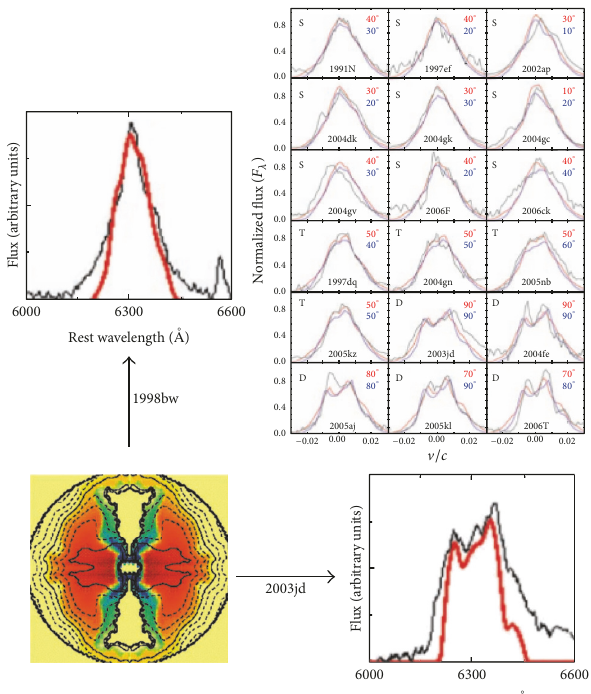
Figure 11: Observed [O i] 𝜆𝜆 6300,6364 emission-line profiles for a sample of SNe Ibc. Top right: emission lines classified into characteristic profiles (from [222]): single-peaked (S), transition (T), and double-peaked (D). Model predictions from a bipolar model (red curves) and a less aspherical model (blue), for different viewing directions are shown (directions denoted by the red and blue text). All other panels: nebular line profiles observed for an aspherical explosion model for different viewing angles (from [113]). The figure shows the properties of the explosion model: Fe (coloured in green and blue) is ejected near the jet direction and oxygen (red) in a torus-like structure near the equatorial plane. Synthetic [O i] 𝜆𝜆 6300,6364 emission-line profiles are compared with the spectra of SN 1998bw (top left) and SN 2003jd (bottom